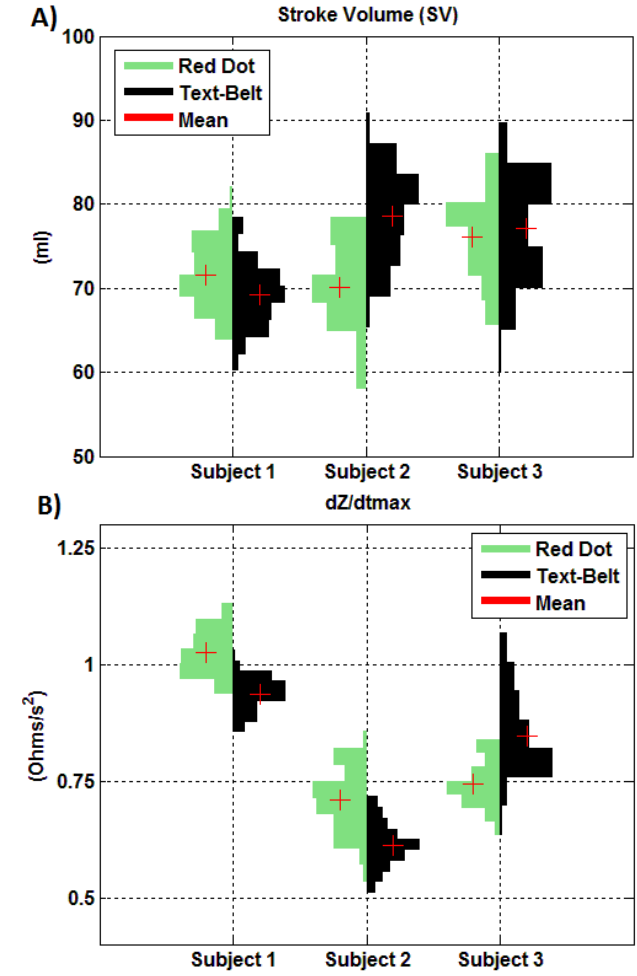
Fig. 7 Estimated parameters showing the distribution plots and mean values. (A) Stroke volume estimation based on equation (1) and (B) peak first time derivative